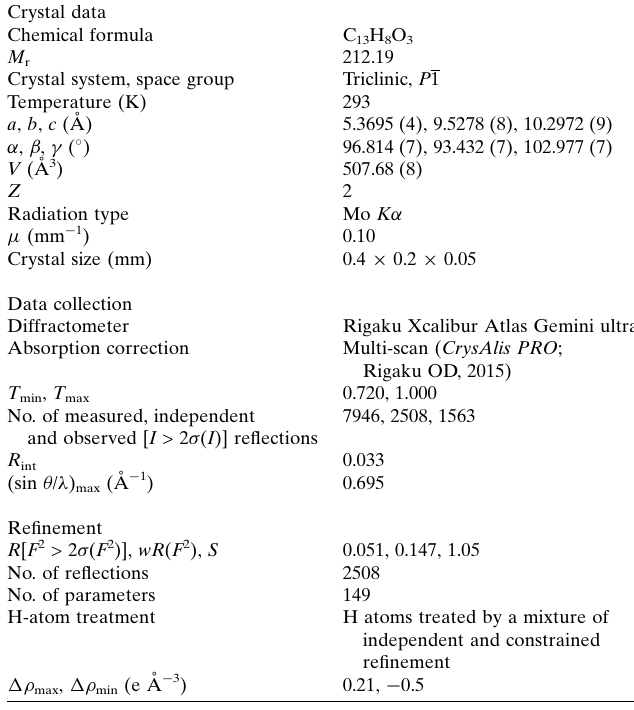
Table 2 Experimental details. Crystal data Chemical formula